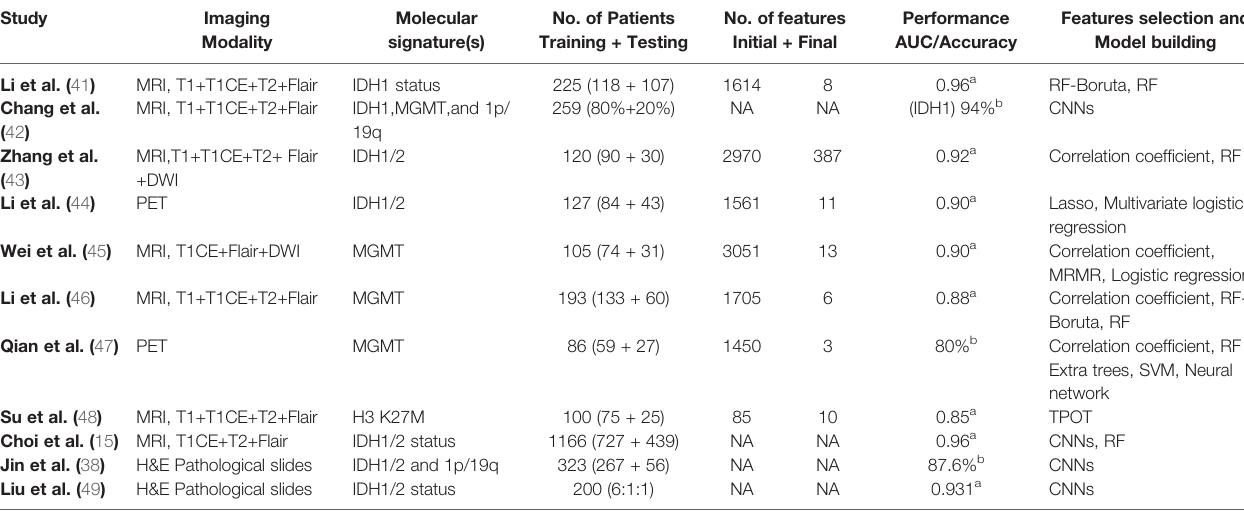
TABLE 1 | Applications of radiomics for predicting speci fi c molecular markers in